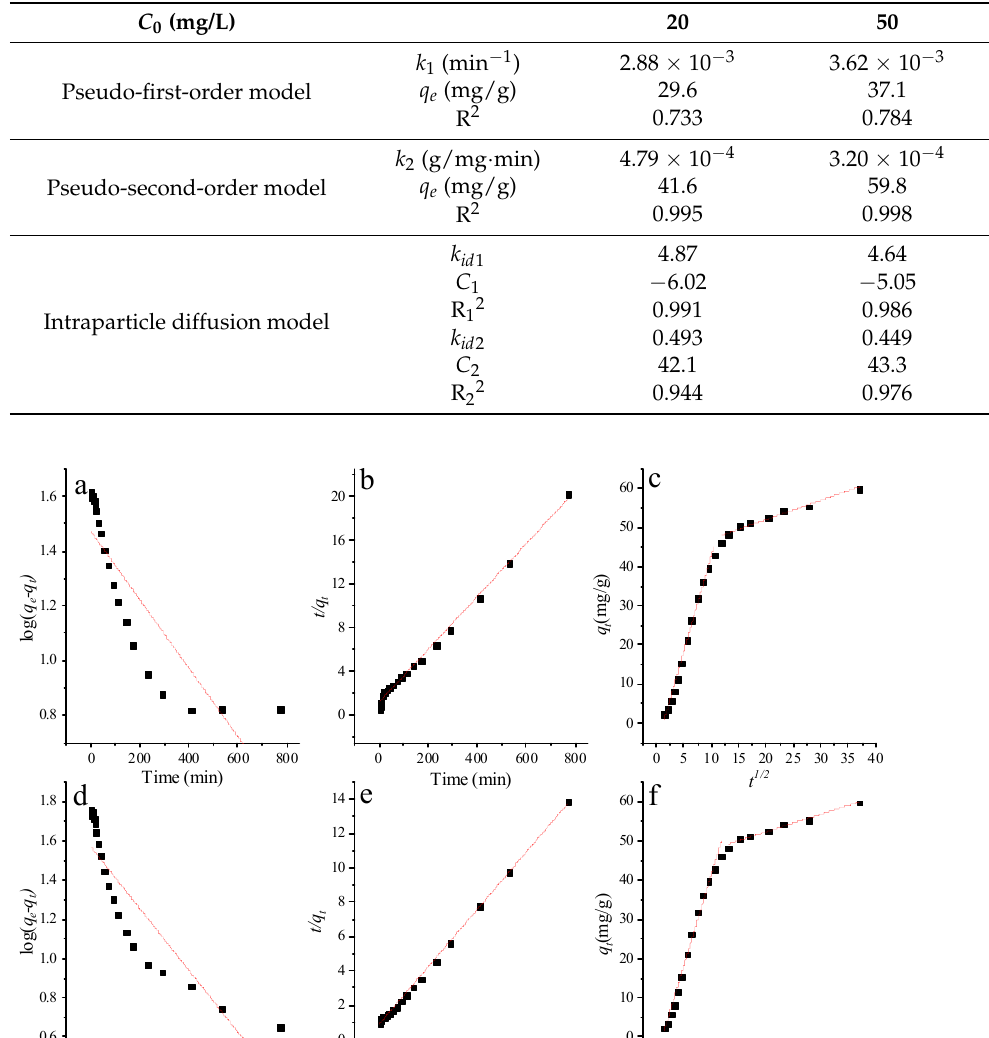
Table 2. The kinetic constant of adsorption of MB on PGO aerogels.